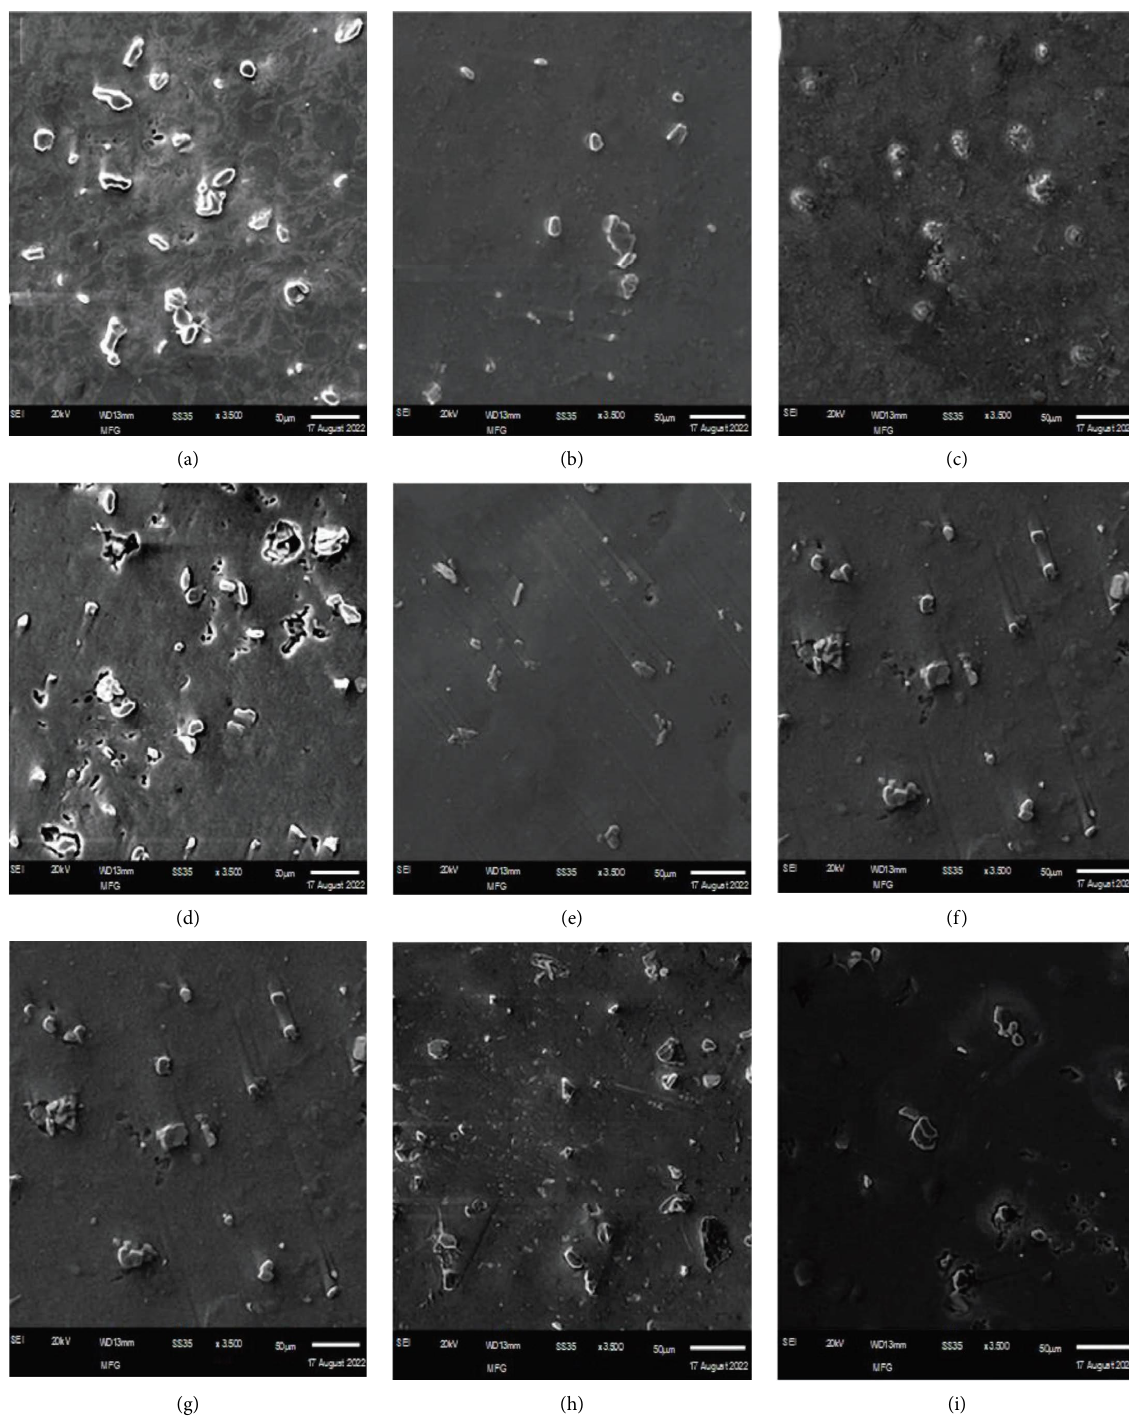
Figure 3: SEM micrographs of SPS specimen (a) specimen 1, (b) specimen 2, (c) specimen 3, (d) specimen 4, (e) specimen 5, (f) specimen 6, (g) specimen 7, (h) specimen 8, and (i) specimen